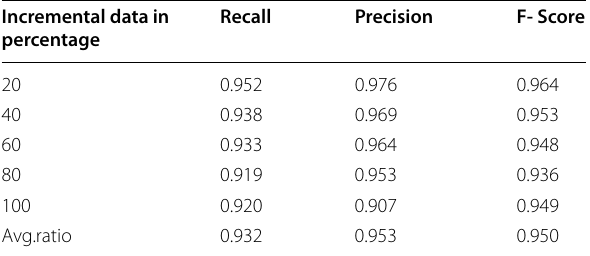
Table 1 Evaluation Metrics